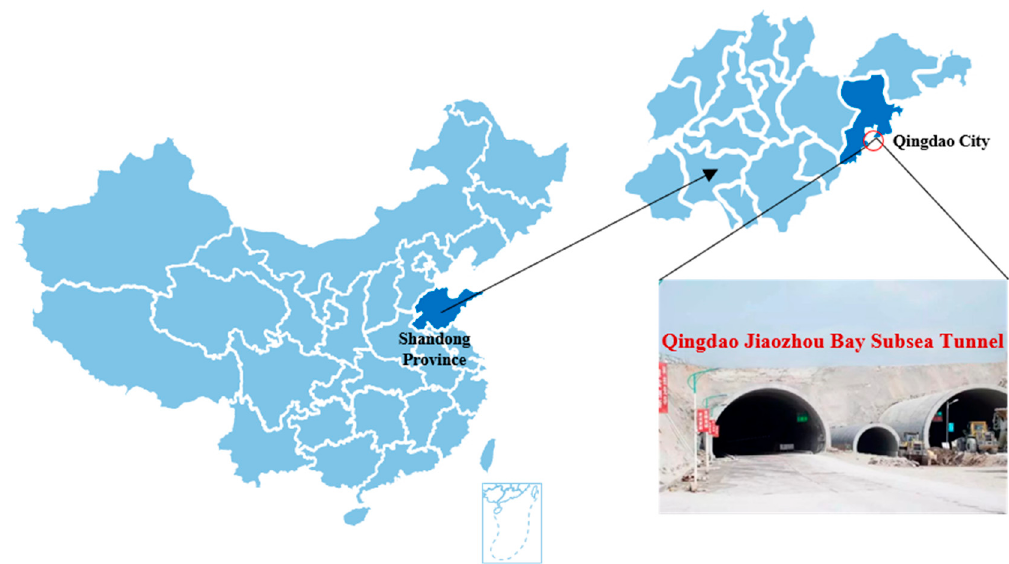
Figure 3. Geographic location of Qingdao Jiaozhou Bay Subsea Tunnel.